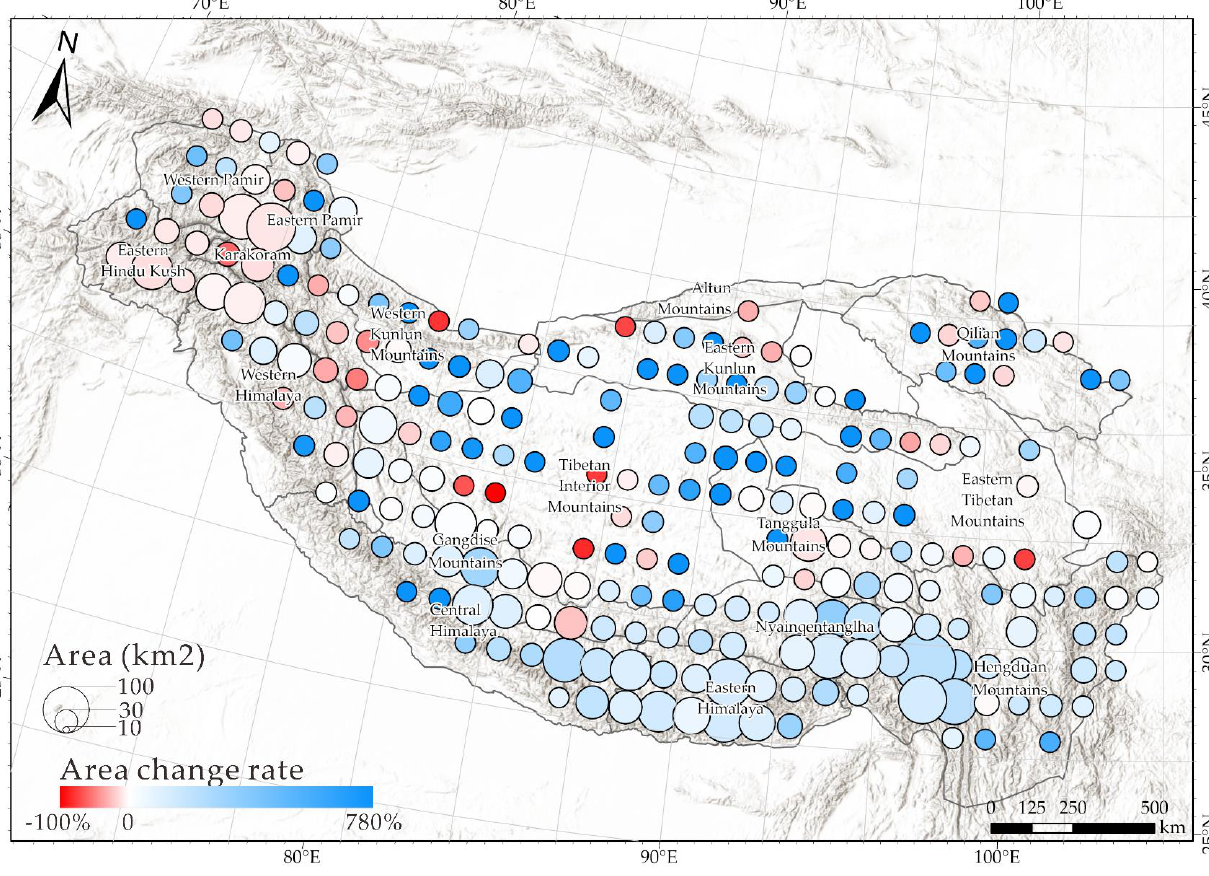
Figure 8. Area change rate of glacial lakes from the first period (1990 − 1999) to the last period (2013 − 2019) on 1 ◦ × 1 ◦ grids in various mountain regions. The circle size represents the total glacial lake area in the first period of each grid. The hillshade basemap is sourced from